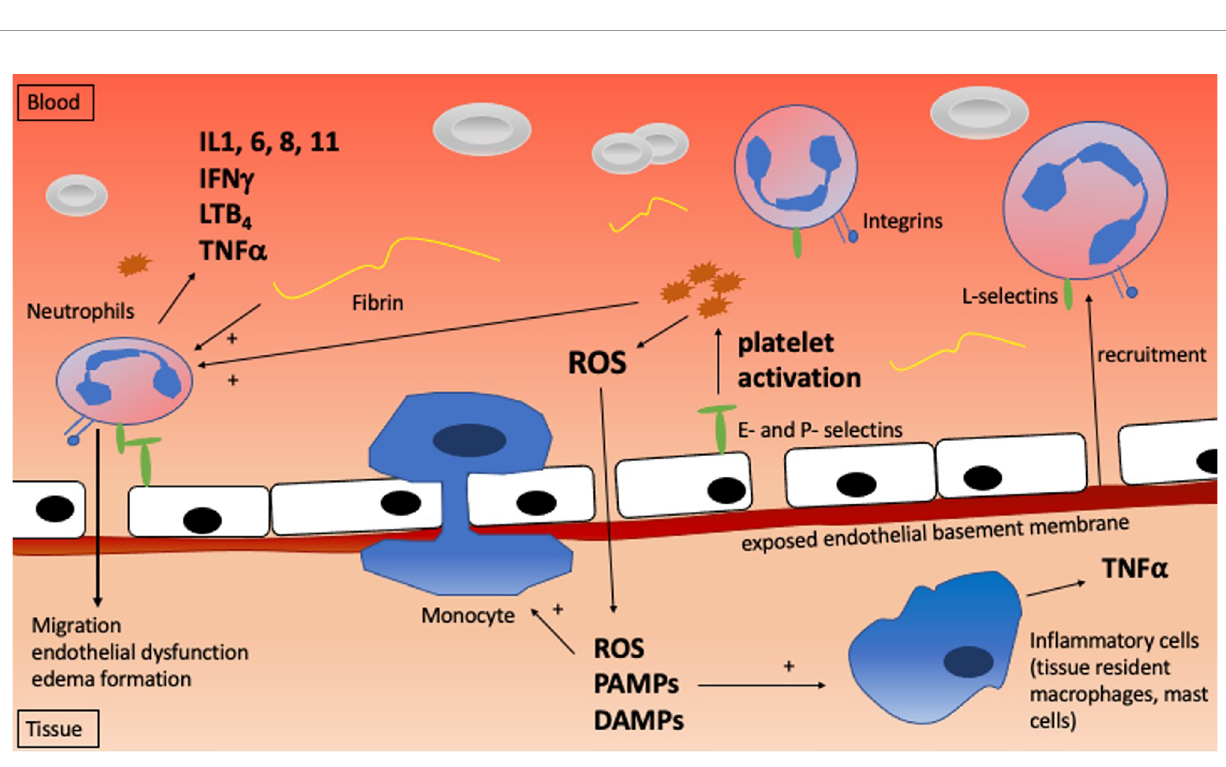
FIGURE 2 | The systemic mechanisms involved with ischemia reperfusion